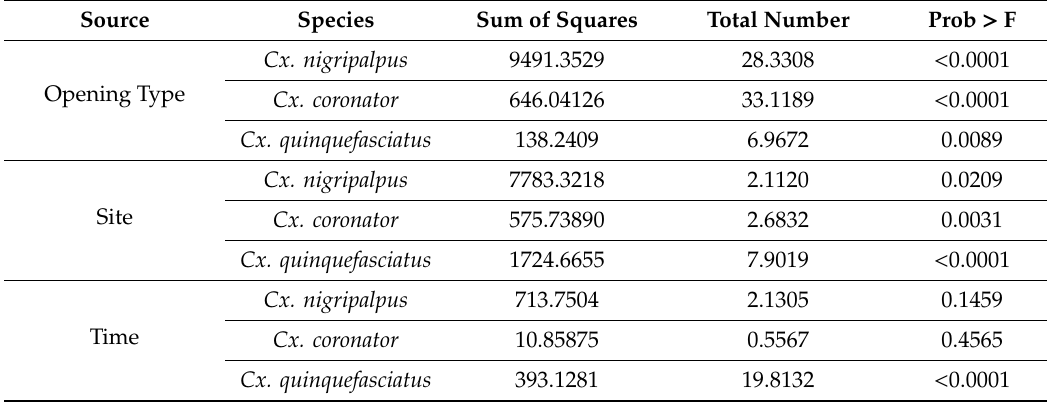
Table 1. E ff ect of cover opening configuration (top), site, and collection day (time) on oviposition in three Culex species using ANOVA.